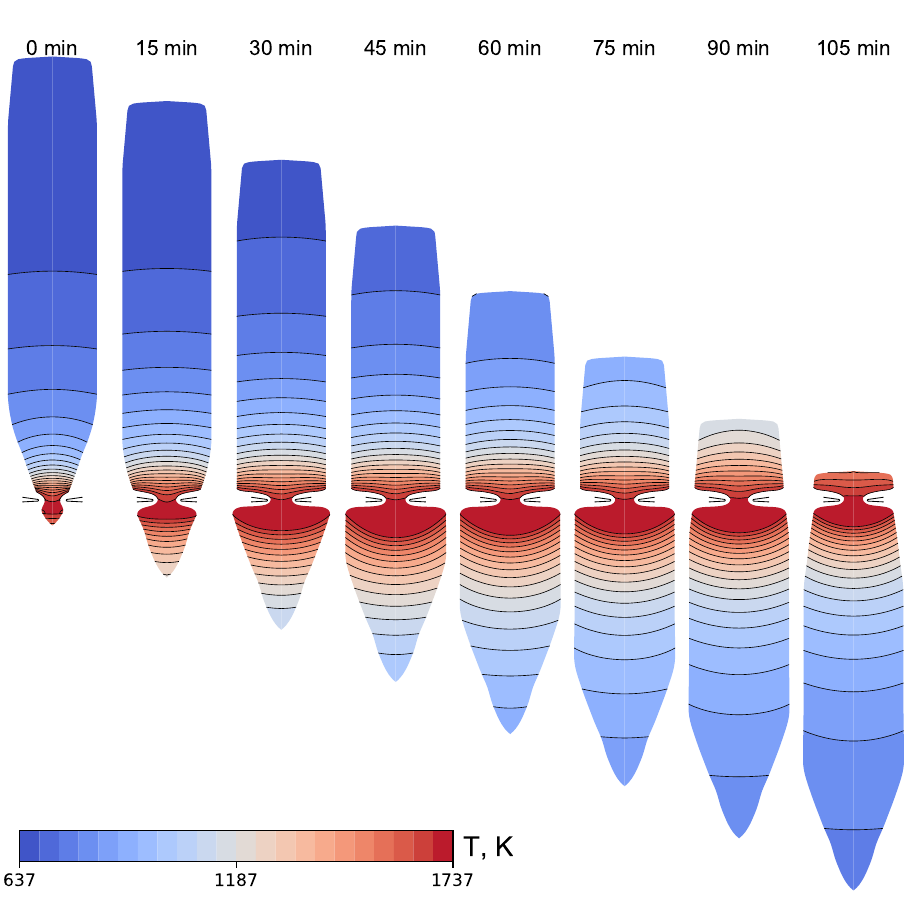
Figure A1. The time-dependence of the shape of the phase boundaries and global temperature field in Si plotted each 15min. The spacing between isotherms is